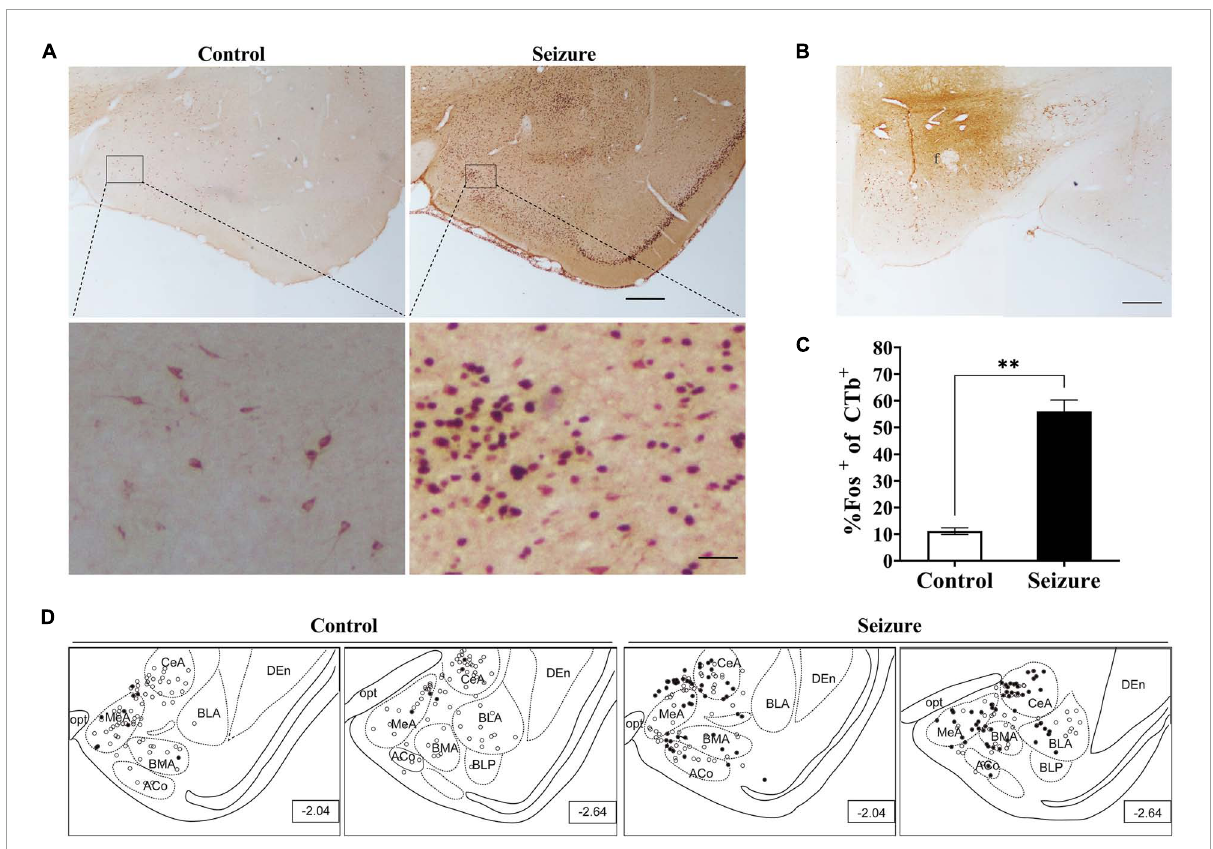
FIGURE5 Pilocarpine-induced statis epilepticus (SE) caused significant activation of amygdaloid neurons projecting to the perifornical region of the hypothalamus. (A) Representative images of Fos (dark purple to black) and CTb (brown) immunostaining in the amygdala in a control and a pilocarpine-treated (seizure) rat pre-injected with CTb in the perifornical region (B) . Bar: 500 µ m in upper panels of (A) and in (B) , and 60 µ m in lower panels of (A) . (C) Bar graph showing the proportions of CTb-labeled amygdala neurons that were activated (Fos + ) in control and seizure rats. ∗∗ P < 0.01, n = 2 rats for each group, Student’s t -test. (D) The distribution of Fos + or Fos − CTb-labeled neurons in 4 rostral-caudal sections of the amygdala in control and seizure rats, with each clear circle representing 1 Fos − CTb-labeled neuron and each filled circle representing 1 Fos + CTb-labeled neuron. The numbers on the right lower corner of each sections indicate the distance from the bregma. ACo, anterior cortical amygdaloid nucleus; BLA, basolateral amygdaloid nucleus; BLP, basolateral amygdaloid nucleus, posterior part;